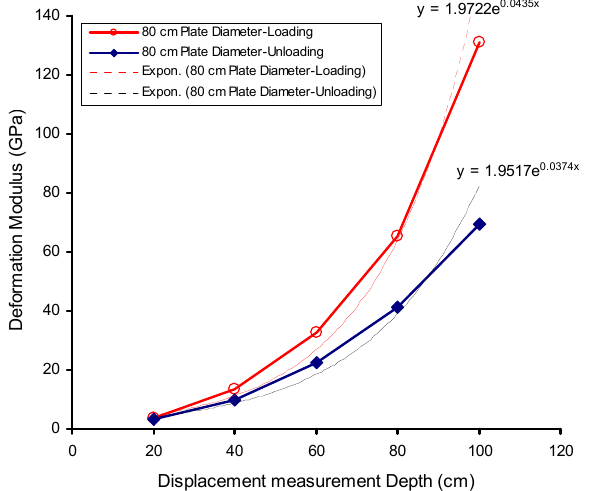
Figure 12. The sensitivity of the deformation modulus to measurement depth in the plate load test.